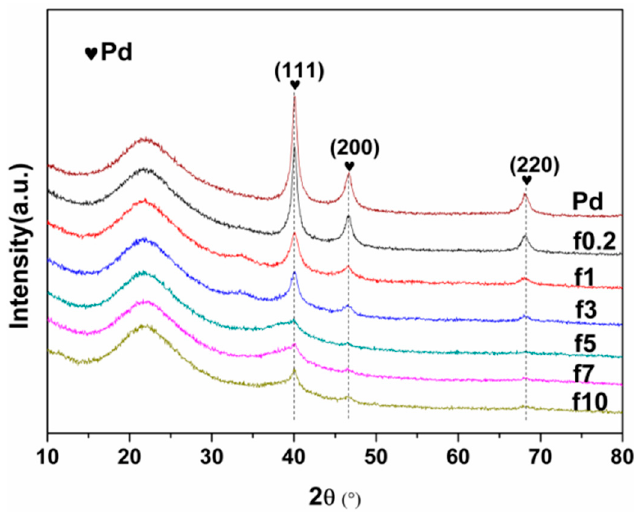
Figure 1. X-ray di ff raction (XRD) patterns of freshly prepared catalysts sulfurized with di ff erent Figure 1. X-ray diffraction (XRD) patterns of freshly prepared catalysts sulfurized with different H 2 S H 2 S concentration. concentration. Table 1. Average particles size of freshly prepared catalysts sulfurized with di ff erent H 2 S concentration. Catalyst